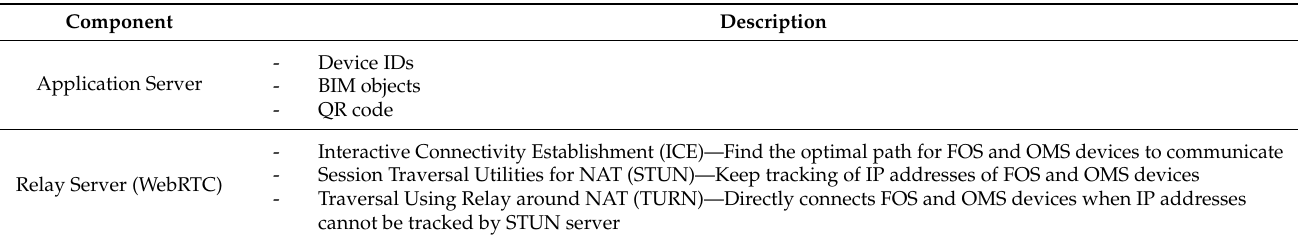
Table 3. Communication Server modules.